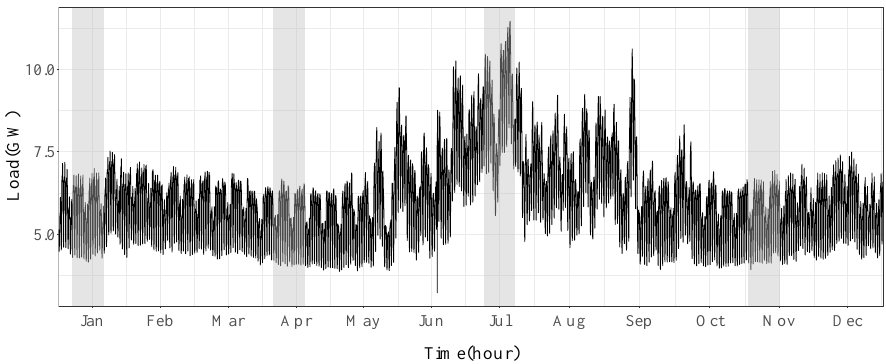
Figure 10. Selected time intervals for testing (NYC zone). The results of the zonal MAPE (MAE) over the corresponding time periods, for fore- casted (f) and real (r) temperature values, are given in Table 4. The expected MAPE values for each zone are given in the last